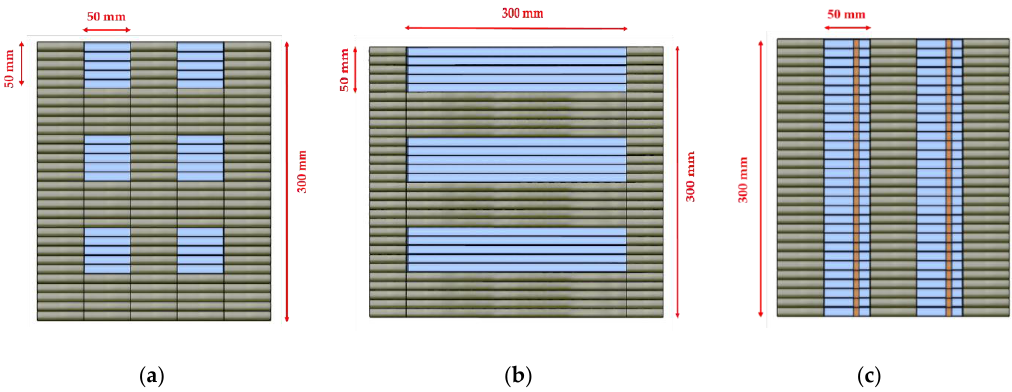
Figure 8. Extracting mortar specimens from the structures. ( a ) Cubic specimens for compressive and splitting tensile tests; ( b ) Prismatic specimens for flexural tensile tests under loading directions I and II; ( c ) Prismatic specimens for flexural tensile tests under loading direction III.